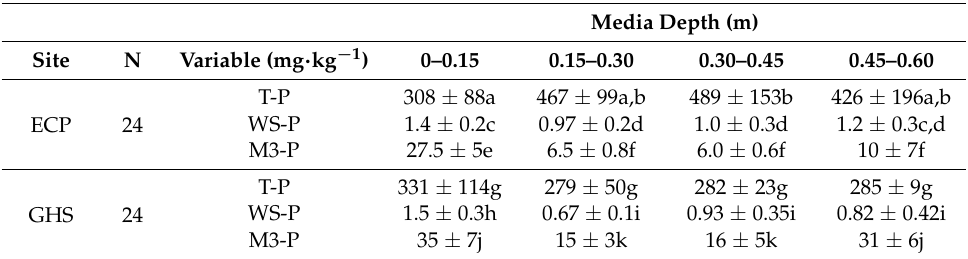
Table 3. Phosphorus concentration (mean ± SD) on bioretention media depths in 2014 samples Grove,